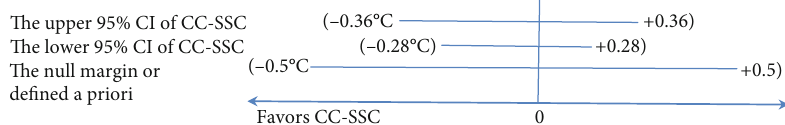
Figure 5: Comparison of the 95% CI of the comparator ’ s SD (current result) versus the priori de fi ned